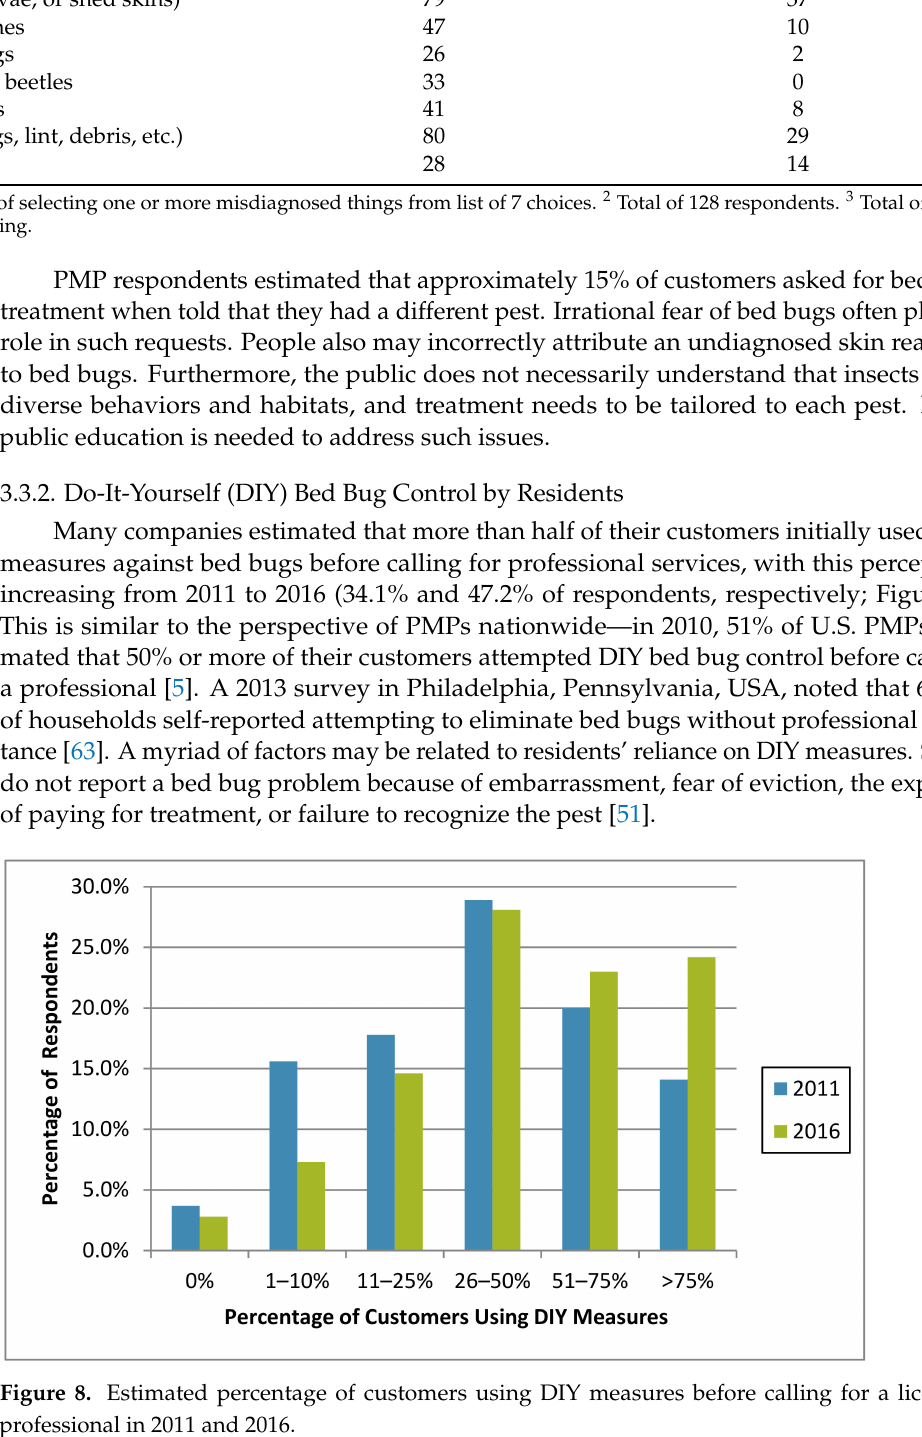
Table 3. Insects or things that customers misdiagnosed as bed bugs according to 2016 survey respondents. Insects/Things Misdiagnosed as Bed Bugs